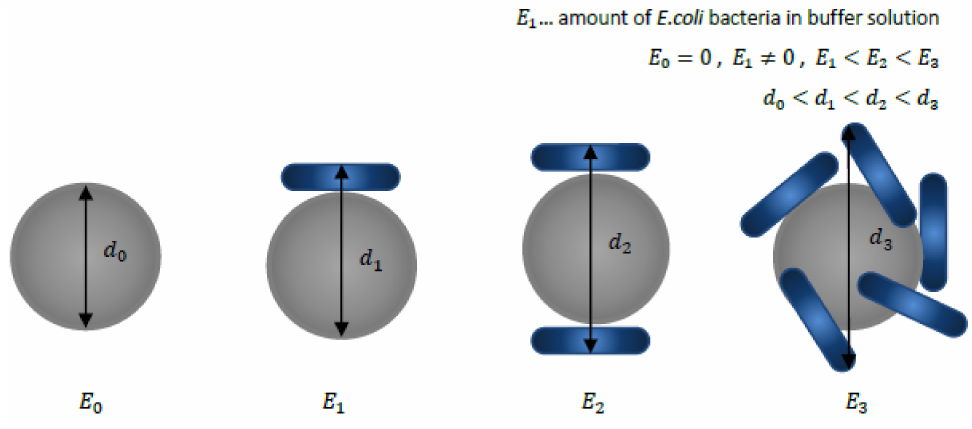
Figure 1. Schematic representation of the volumetric changes of a functionalized magnetic particle (MP) with respect to the number of E. coli bacteria attached to its surface. The amount of the attachments depends on the amount of E. coli bacteria present in a buffer solution. The diameter d 0 corresponds to a reference diameter of a plain, not functionalized, unloaded MP without any E. coli bacteria attached. The variables d 1 , d 2 and d 3 indicate the sizes of the compounds formed (magnetically labelled bacteria (MLB)) when the concentration of E. coli bacteria within the water solution